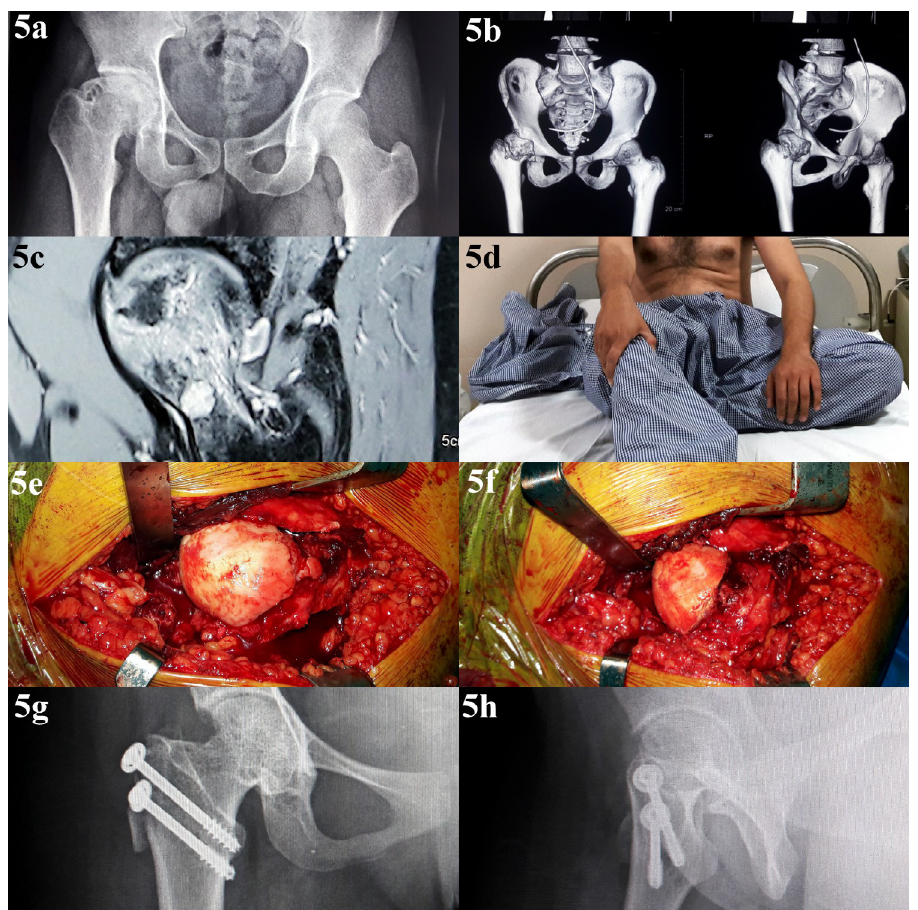
Figure 5. Follow-up of a 35-year-old male presenting with symptoms of hip impingement after steroid-induced ONFH; panel a: preoperative radiograph showing cam deformity in right femoral head; panel b: preoperative CT scan showing extent and location of cam deformity in the femoral head; panel c: MRI scan earlier in the course of disease-con fi rming changes of ONFH; panel d: clinical radiographs showing restricted hip motion due to cam deformity of femoral head; panel e: intraoperative picture showing cam deformity at femoral head – neck junction and preserved articular cartilage; panel f: intraoperative picture after femoral head osteochondroplasty; panels g and h: post-operative radiographs showing restoration of femoral head